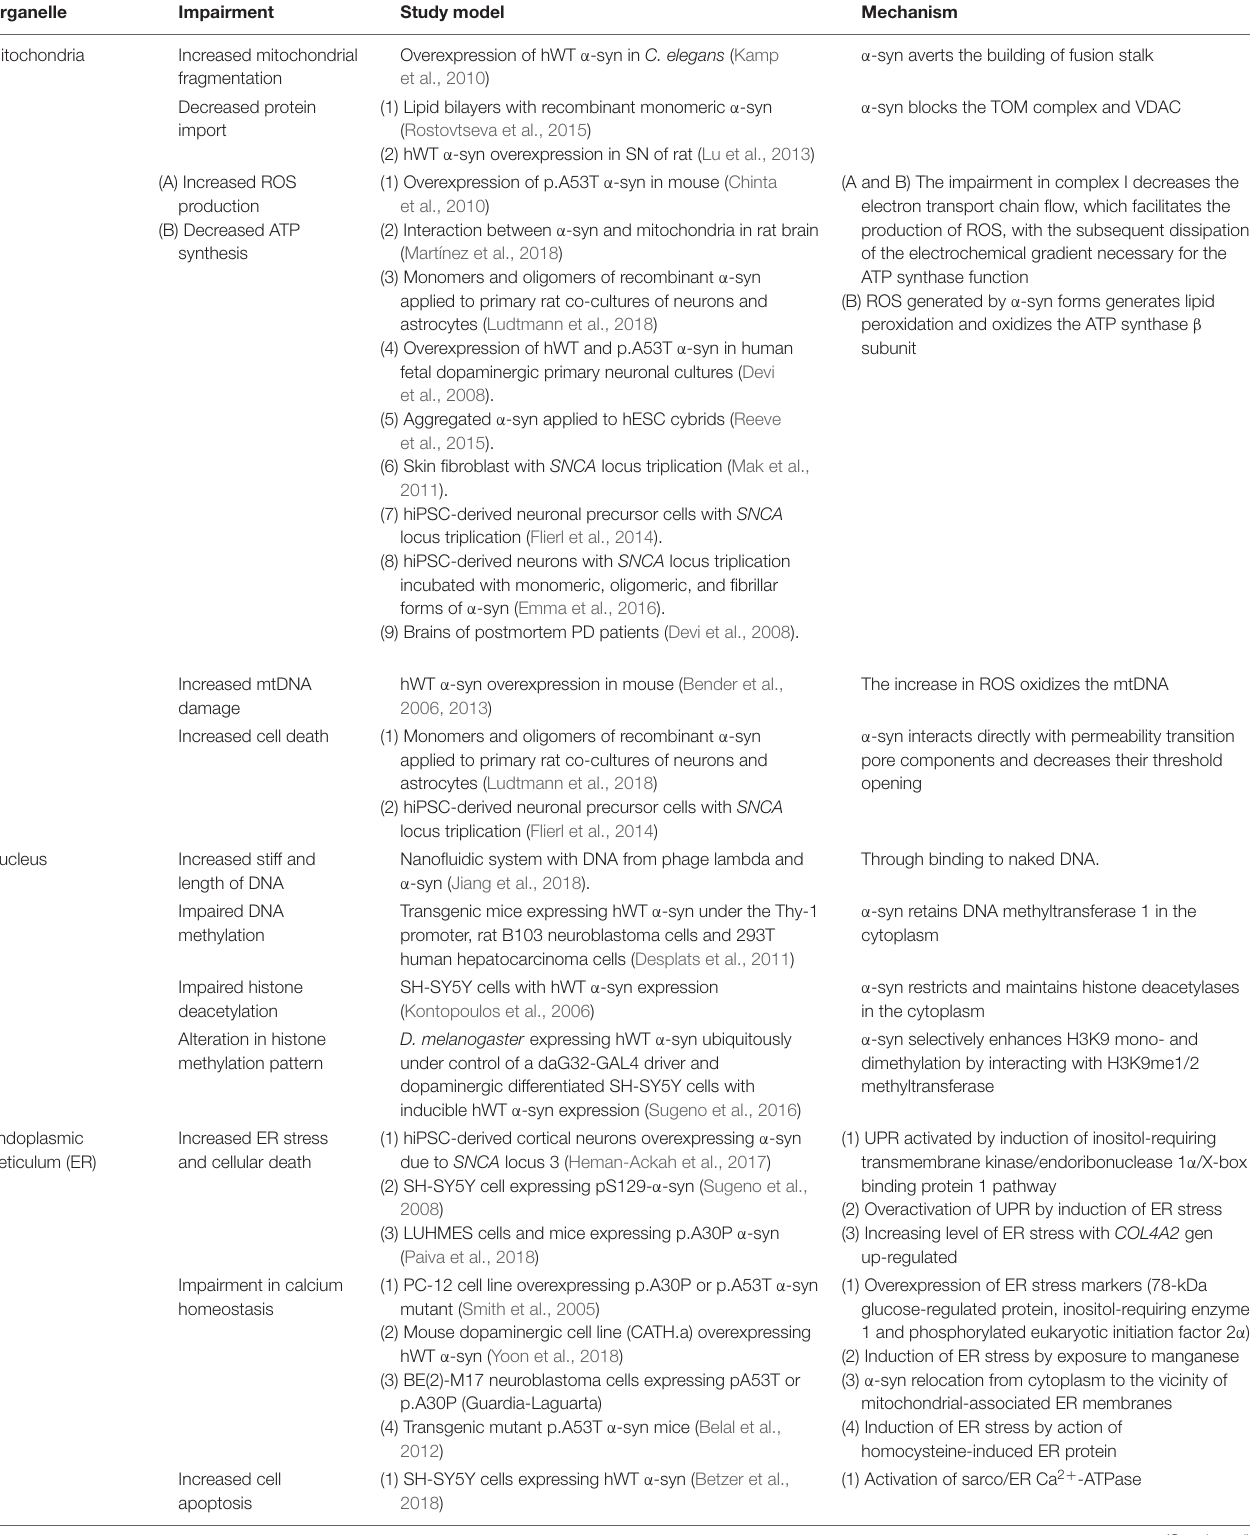
TABLE 1 | Impairments in different organelles related to α